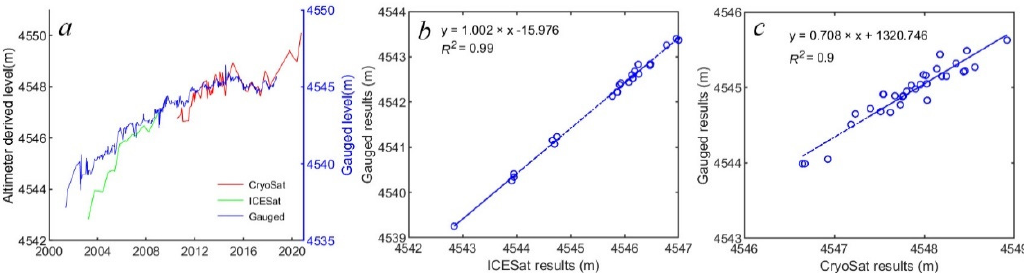
Figure 2. Comparisons between ICESat and CryoSat data and gauged measurements of Selin Co in 2000–2020 ( a ). ( b ) and ( c ) indicate correlations between the two kinds of altimeter results and in-situ results, respectively.